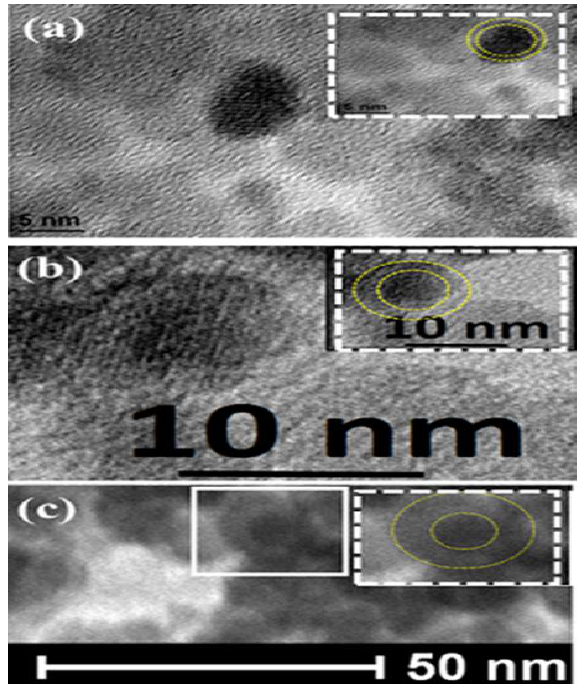
Figure 3. The high-resolution TEM (HRTEM) of samples ( a ) S1; ( b ) S2; and ( c ) S3. The dotted lines in the insets are guides for the eye and show the boundaries of the cores and shells.